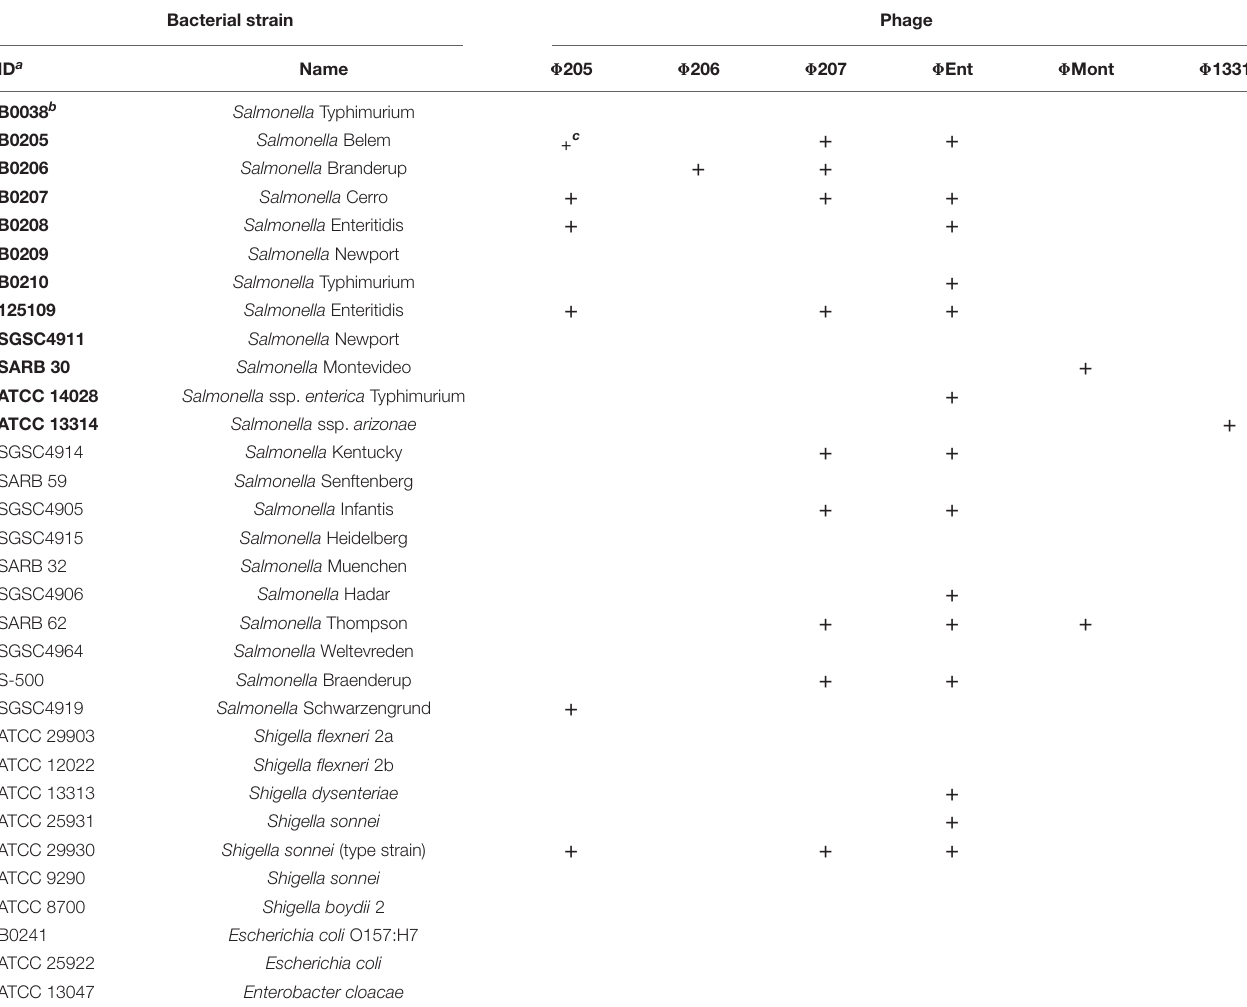
TABLE 2 | Host ranges of six Salmonella phages isolated from turkeys. Bacterial strain